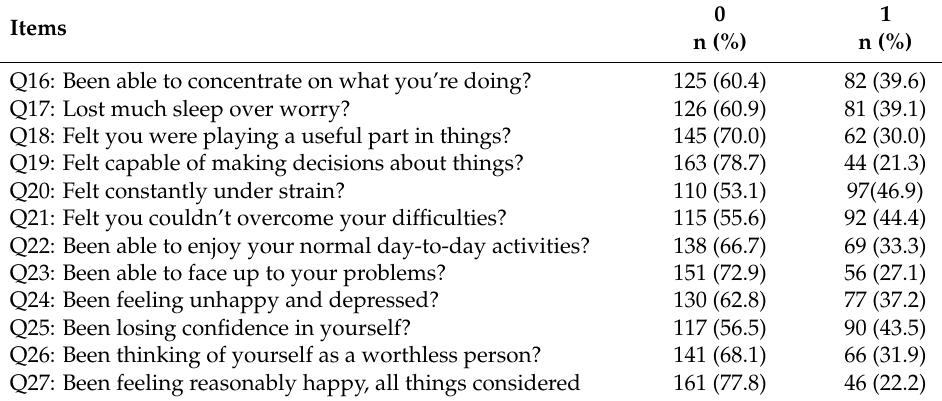
Table 5. Summary of items descriptive of psychological health (n = 207).